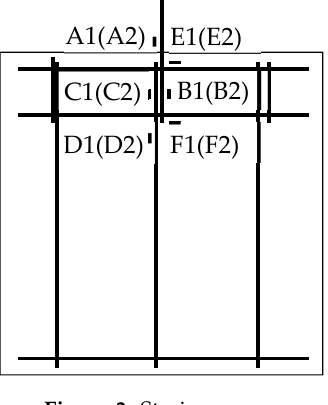
Figure 3. Strain gauges.